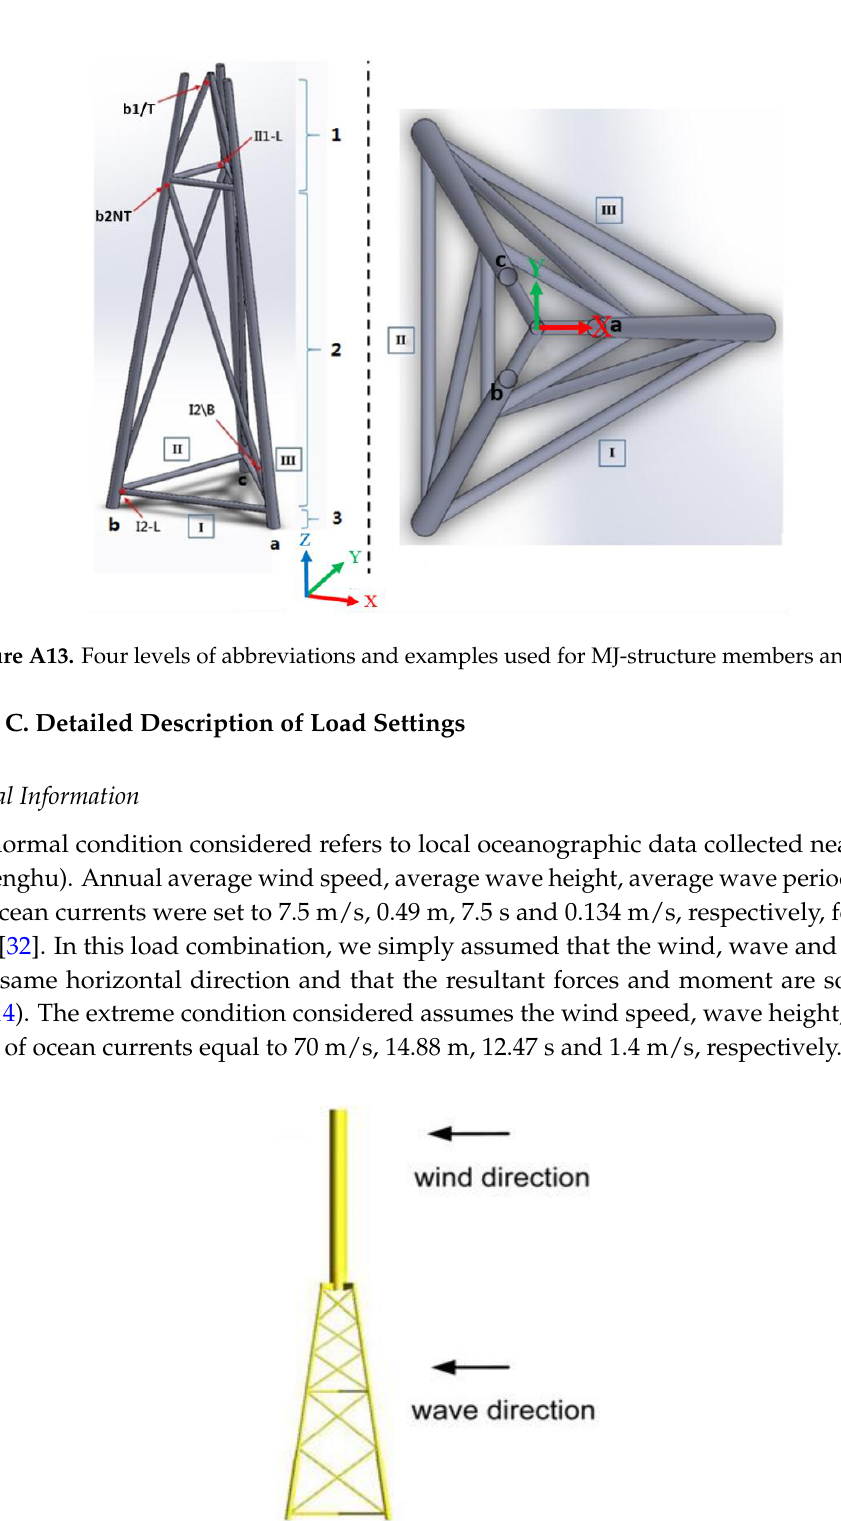
Figure A14. Schematic showing the in-plane winds and waves in the same direction.